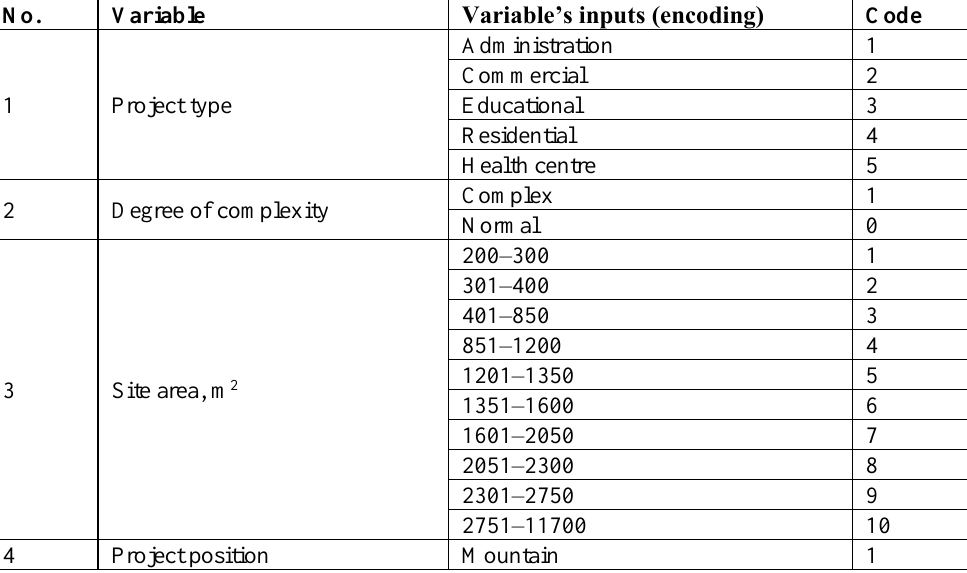
Table 3. Data encoding (developed by the